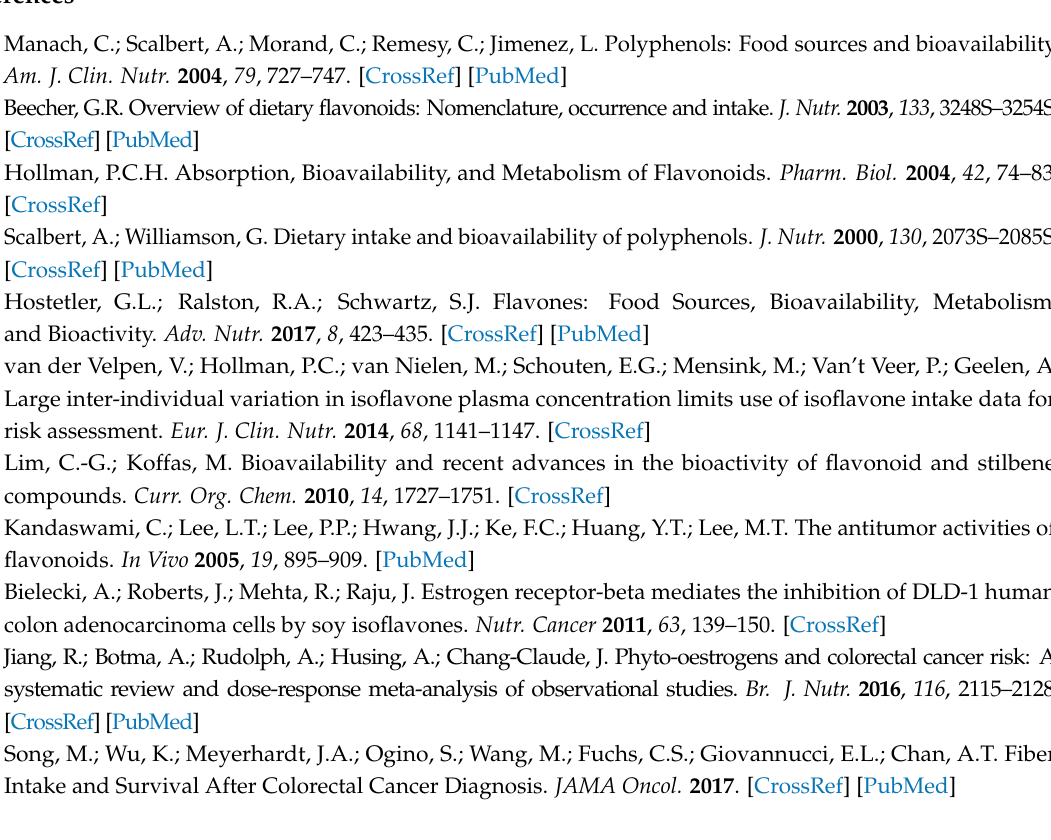
Table S1: Genistein and luteolin concentration by patient characteristics, Table S2: Association between genistein and colorectal cancer prognosis according to different subgroups, Table S3: Association between luteolin and colorectal cancer prognosis according to different subgroups, Table S4: Association of serum genistein and colorectal cancer prognosis by timing of blood drawn, Table S5: Association of serum luteolin and colorectal cancer prognosis by timing of blood drawn, Table S6: Association between genistein and colorectal cancer prognosis by tumoral molecular